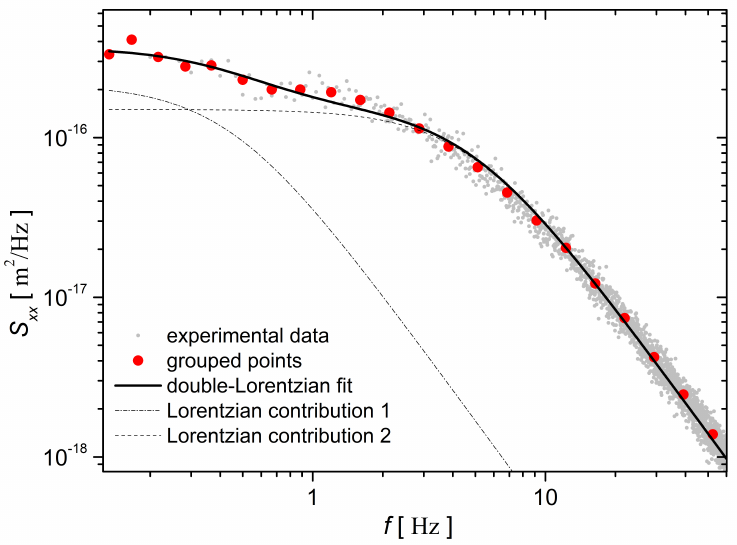
Figure 3. Power spectral density of microsphere fluctuations. The solid line belongs to the model according to Equation (29). The fit was set after optimization of Obj _ F ( Par ) . Two Lorentzian contributions spanning the entire spectrum are also